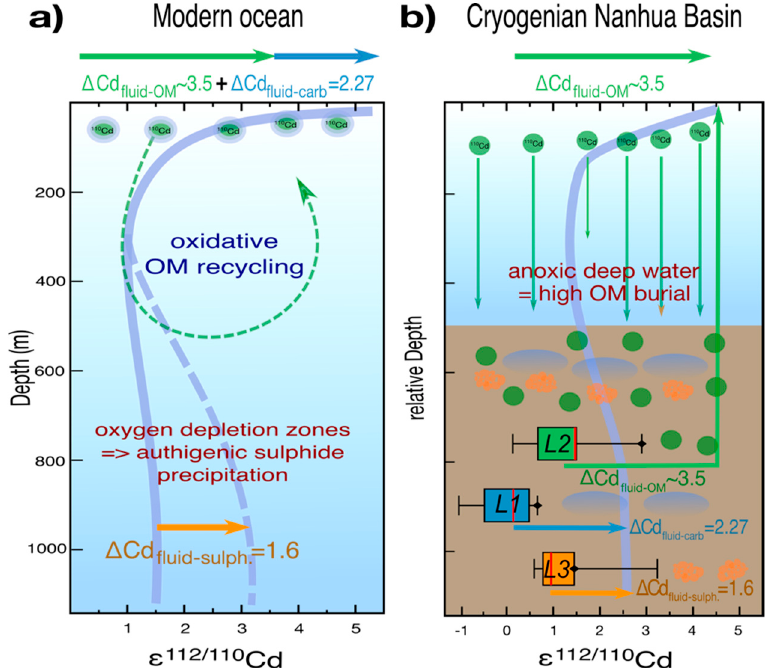
Figure 5. Behaviour of Cd isotopes in the modern ocean ( a ) and in the Cryogenian Nanhua Basin ( b ). ( a ) Schematic model for the Cd isotope ‘nutrient-like’ depth profile in the modern oceans. Cd isotopes are fractionated from the continental derived input in the photic zone via biological uptake leading to progressively ‘heavy’ Cd-enriched surface waters. This effect may be accompanied by fractionation of the Cd pool into carbonate tests with a further positive fractionation factor. Sinking dead biomass within the water column can be oxidized and the Cd gets recycled, causing modern deep waters to have ‘lighter’ Cd isotope compositions. In oxygen minimum zones, the formation of authigenic Cd sulphides under the presence of free H 2 S can cause further isotope fractionation and a shift to ‘heavier’ deep water values. ( b ) Schematic model of a theoretical Cd isotope profile in the redox stratified Cryogenian Nanhua Basin. Only Cd utilization by algae may fractionate the surface waters’ Cd pool in the photic zone while carbonate shells were not existent. In the anoxic deep and pore waters of the Nanhua Basin the formation of authigenic carbonates and sulphides (represented by the obtained values in the L1 and L3 leachates) shifted deep water Cd isotope compositions that were in isotopic equilibrium with the DOC (recorded in the obtained values from OM leachate L2) to ‘heavier’ values that are above the values recorded in modern oxygenated deep